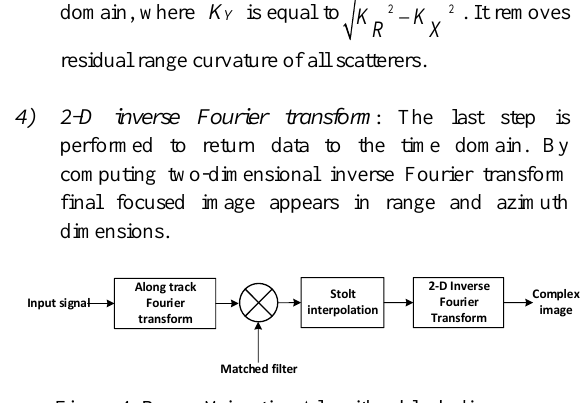
Figure 4. Range Migration Algorithm block diagram